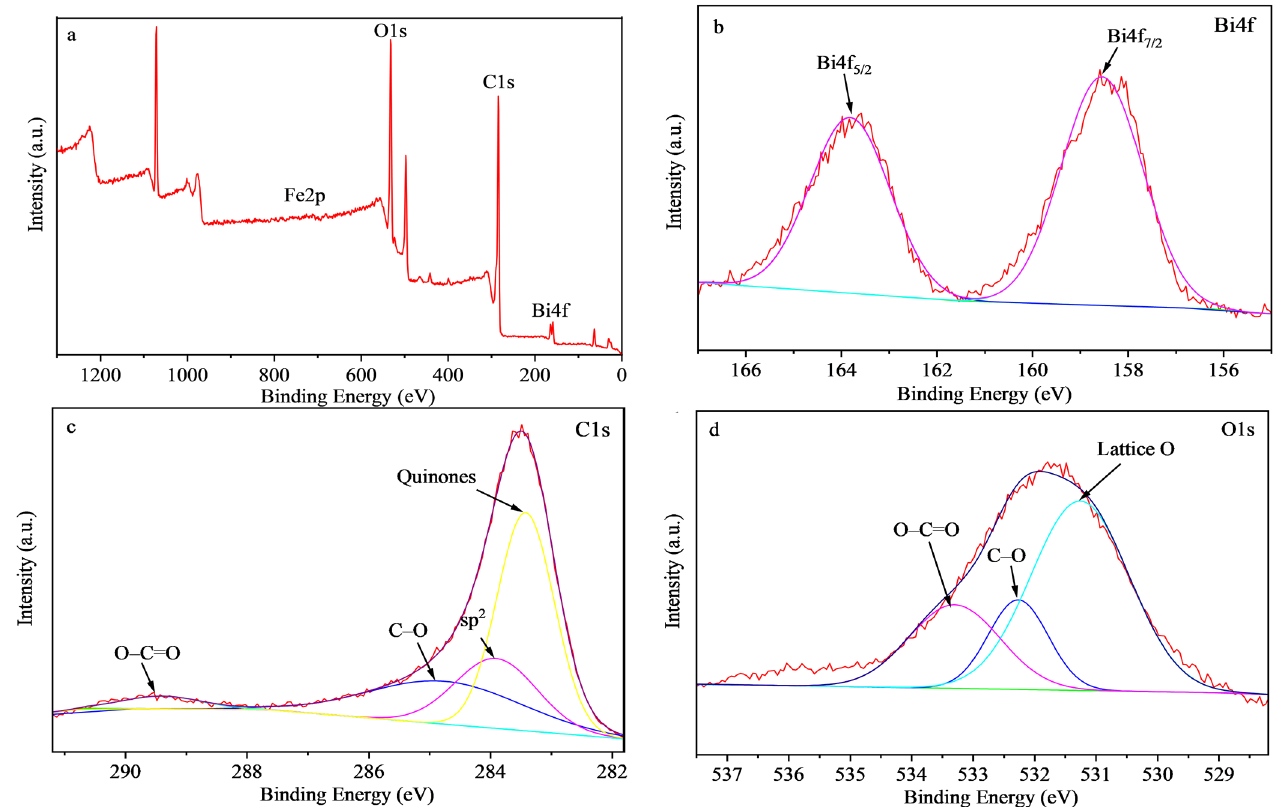
Figure 3. XPS spectra of BiFeO 3 /BC ( a ) survey, ( b ) Bi 4f, ( c ) C 1s, and ( d ) O 1s.